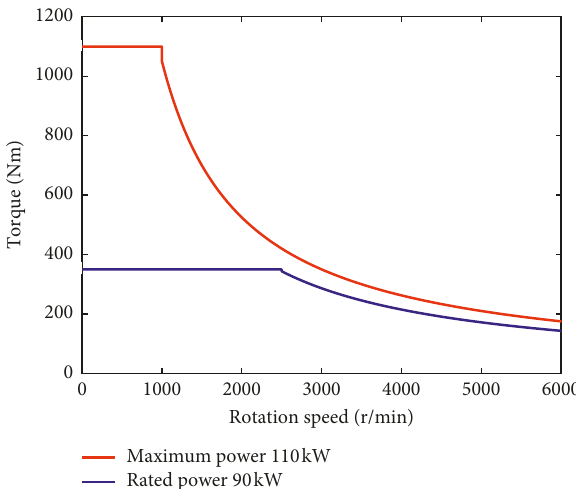
Figure 6: External characteristic curve of the PWSM.